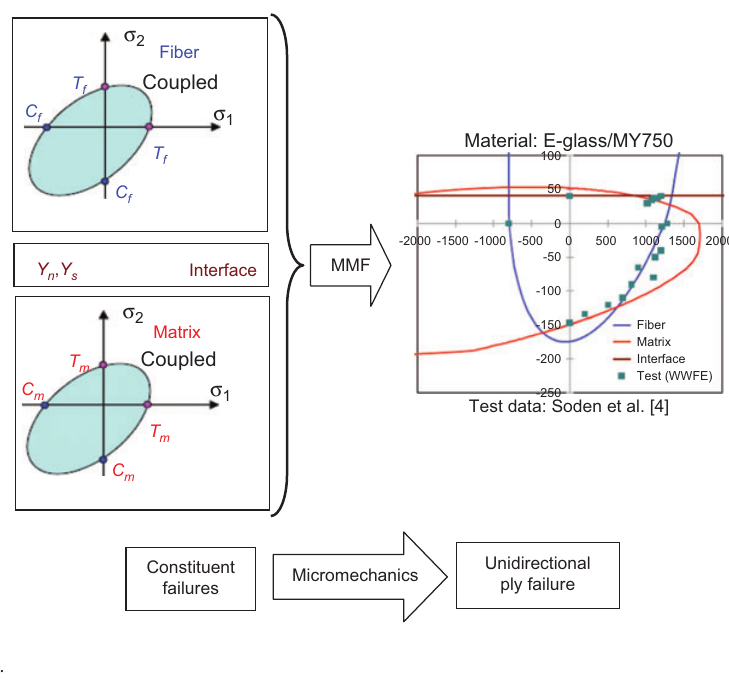
Figure 2 MMF summary.